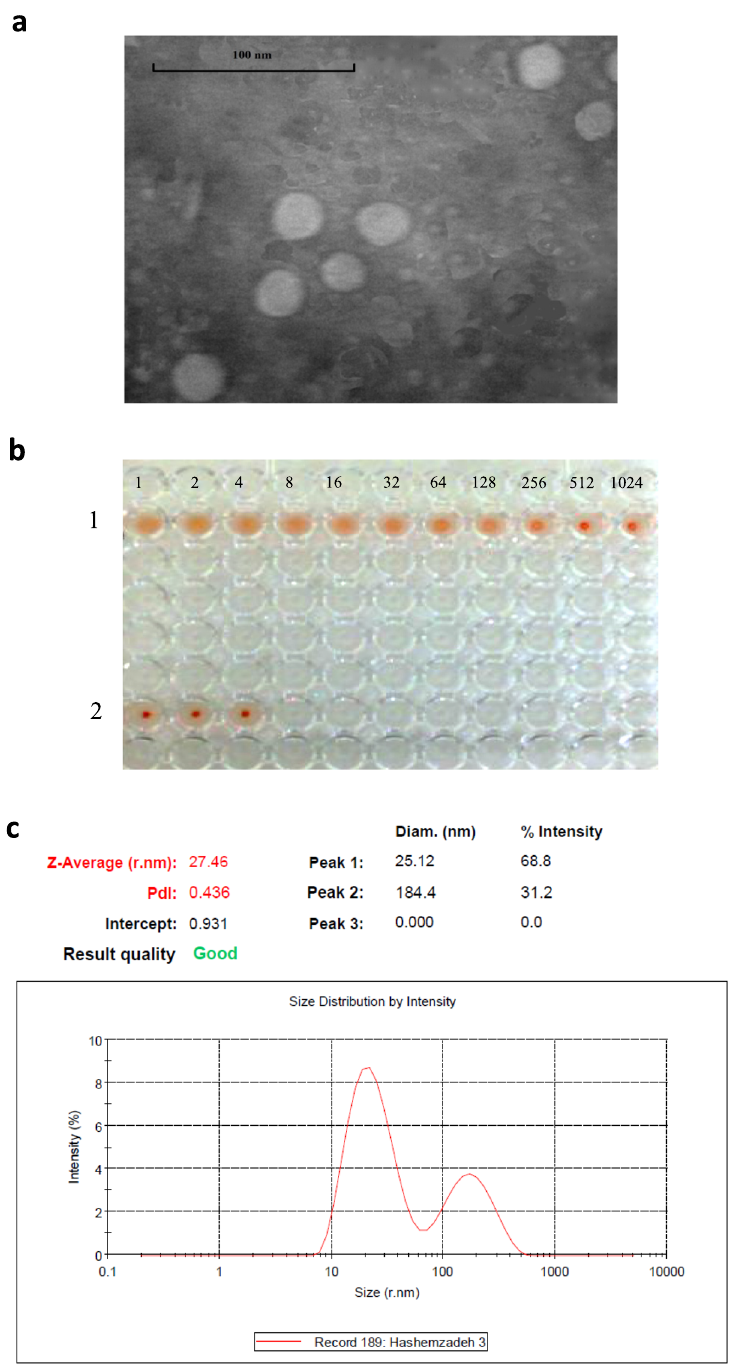
Fig. 6 Evaluation results of the quality and structural integrity of the purifed VLPs by TEM, HA, and DLS. a The purifed VLPs imaged by TEM with a magnifcation of 120,000 X. b HA test in a 96-well U shaped plate. Row 1: The results indicate the strong hemagglutination in the dilutions of 1, 2, 4, 8, and 16 and weakening of hemagglutination in the dilutions of 32, 64, and 128, and fnally, the negative hemagglutination in the dilutions of 256, 512, and 1024. In total, the hemagglutination property of the produced VLPs indicates the quality and structural integrity of these nanoparticles. Row 2: The negative control of HA containing PBS and RBC without the presence of the VLP. c Calculation of the size distribution of CPV-VLP nanoparticles by DLS technique. This analysis shows that 68.8% of the formed nanoparticles had a size of about 25.12 nm and 31.2% of these nanoparticles had a size of about 184.4